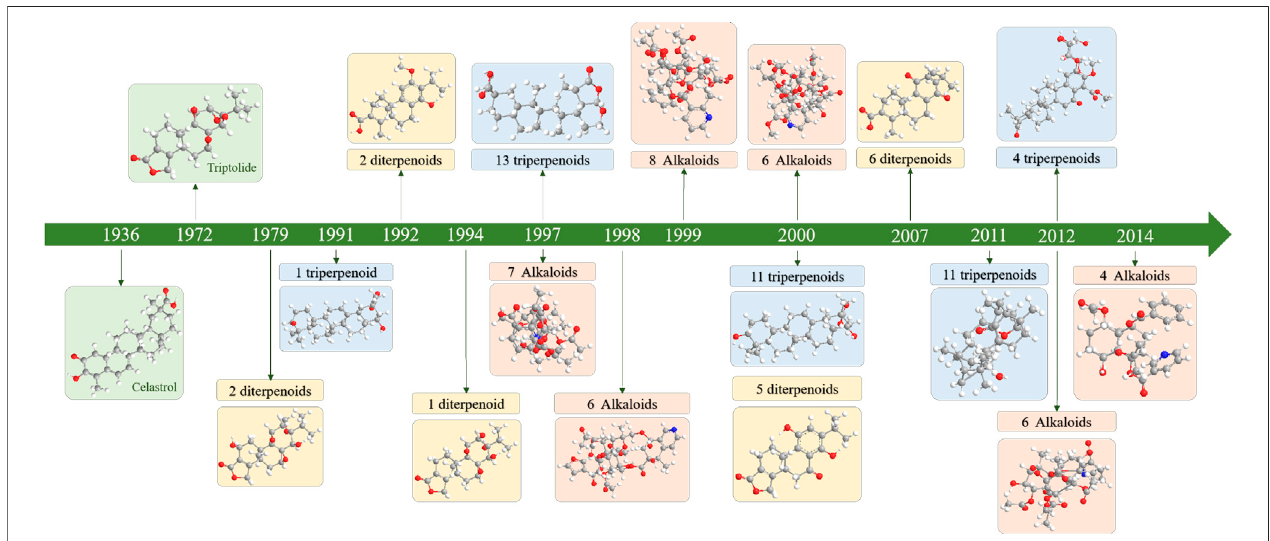
FIGURE 2 | Timeline of the isolation and identi fi cation of main chemical components from the genus Tripterygium .